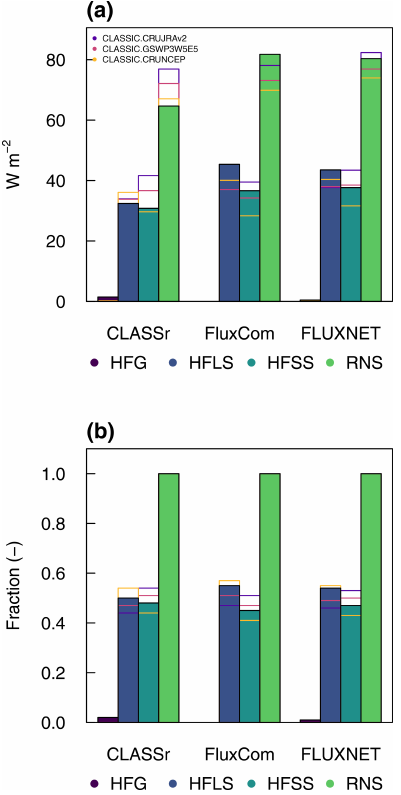
Figure 10. (a) Annual mean values of soil heat flux (HFG), latent heat flux (HFLS), sensible heat flux (HFSS), and net surface ra- diation (RNS) for the three CLASSIC ensemble members and for the reference data (CLASSr, FluxCom, and FLUXNET). Panel (b) shows the corresponding fractions with respect to net surface radia-